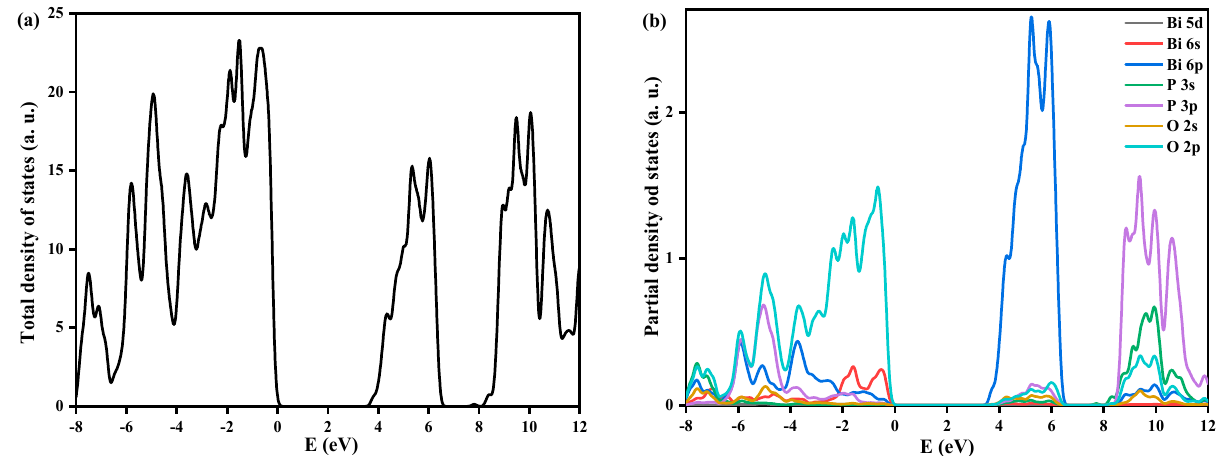
Figure 7. ( a ) Total density of states TDOS and ( b ) partial density of states PDOS of BiP-500. The level is set to fermi level is set to zero.